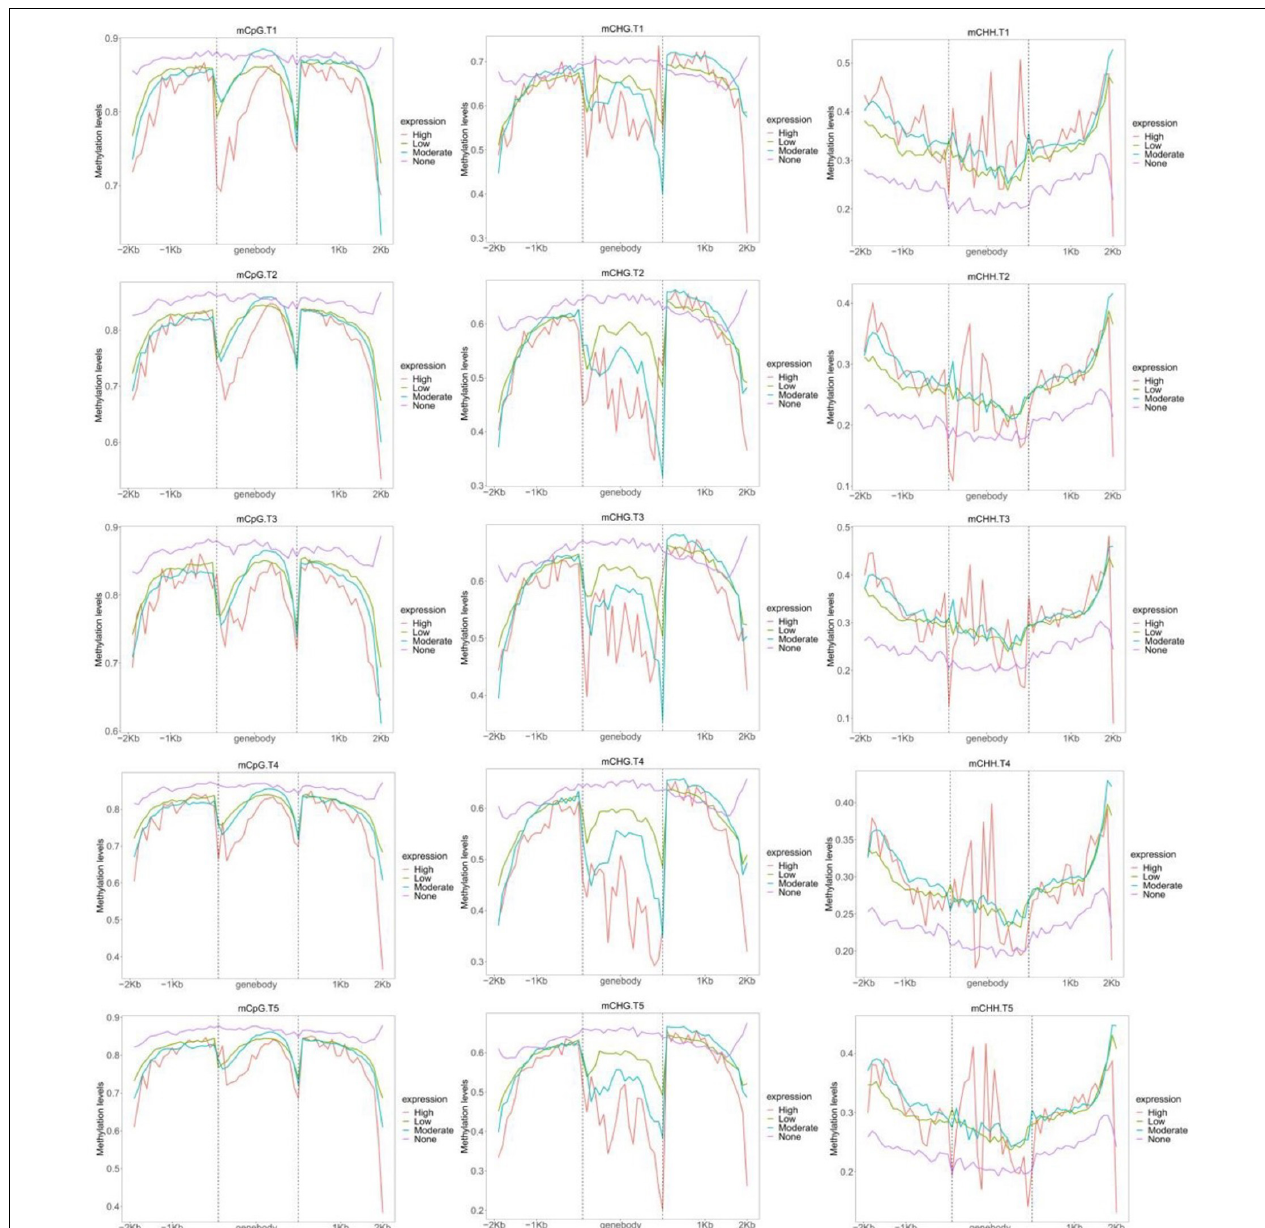
FIGURE 5 | Distribution of CG, CHG, and CHH methylation levels within gene bodies based on four different expression levels: none, high, moderate, and low.